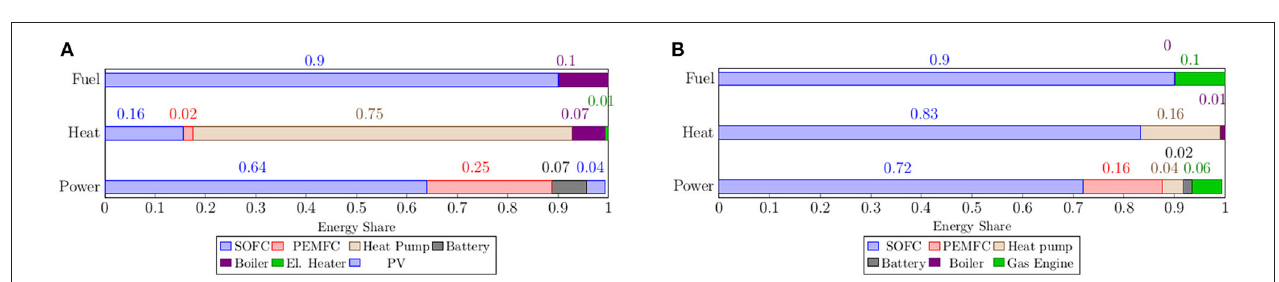
FIGURE 6 | Usage and losses of energy storage. (A) Off-grid dwelling, (B) Cruise ship.